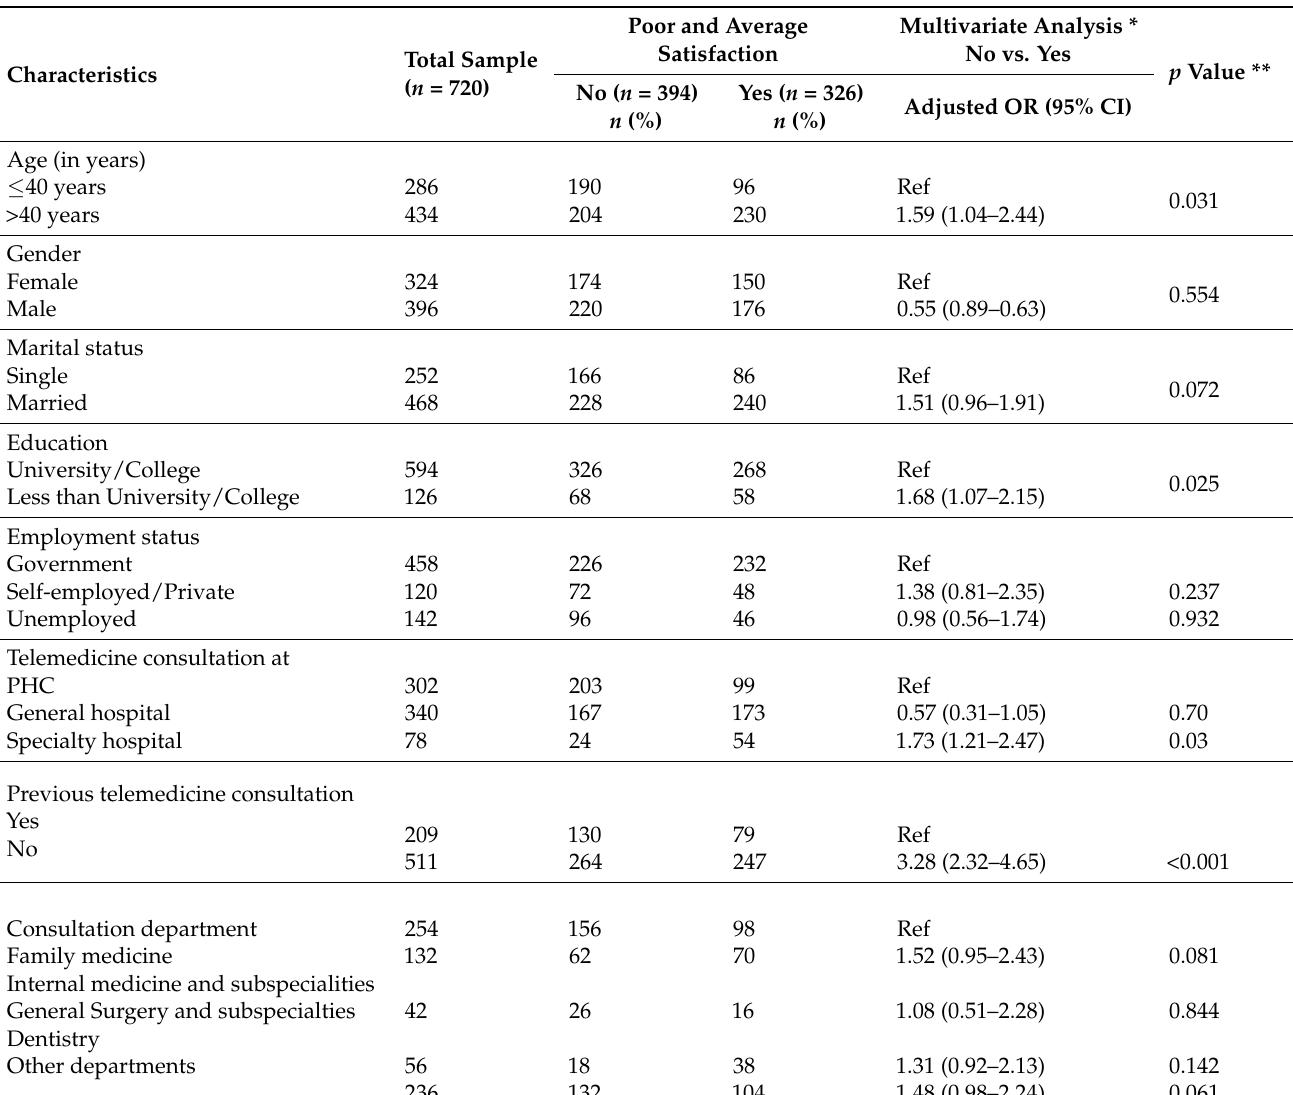
Table 4. Logistic regression analysis on patients’ socio-demographic characteristics with poor and average satisfaction towards